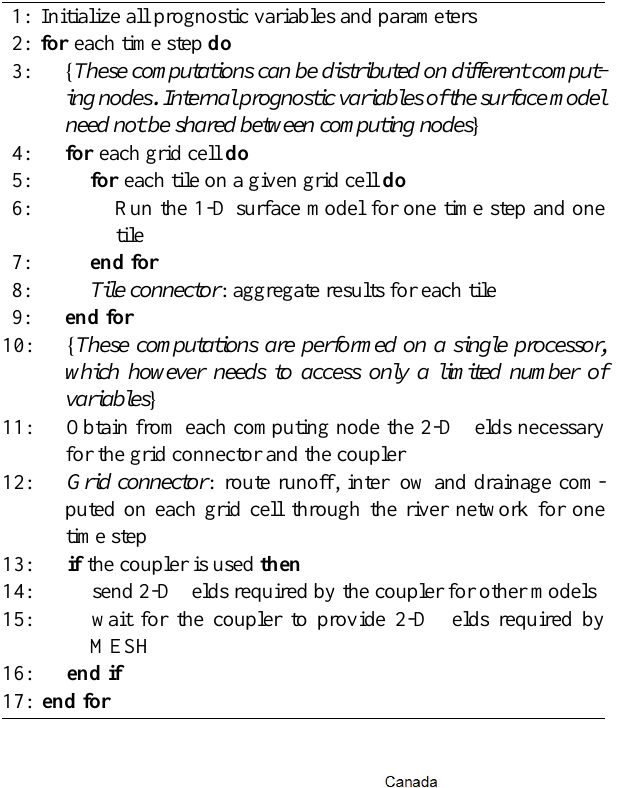
Algorithm 1 MESH time-stepping algorithm